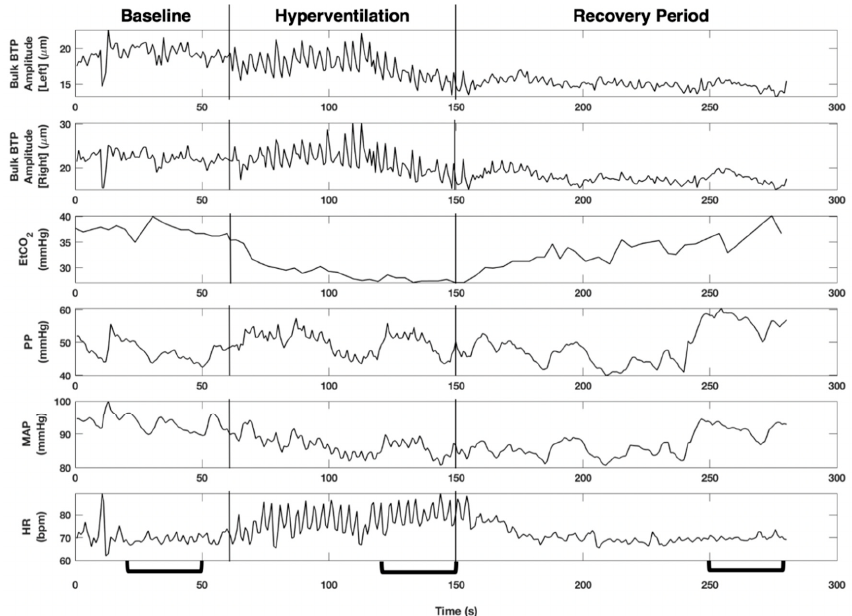
Figure 2. Time series for each variable are shown for an entire recording in which a 26-year-old male performs the hyperventilation manoeuvre. A reduction in EtCO 2 and an increase in heart rate (HR) can be observed during the hyperventilation period, changes in pulse pressure (PP) appear to mirror changes in mean arterial pressure (MAP), and Bulk brain tissue pulsations (BTP) Amplitude shows similar trends for both left and right hemispheres. There appears to be a decrease in Bulk BTP Amplitude and variability during the recovery phase compared to the hyperventilation phase. The brackets on the x-axis indicate the 30 s time intervals used in statistical analysis for this recording. All 30 s intervals were chosen to be close to the end of each phase, while also avoiding the inclusion of artefacts.